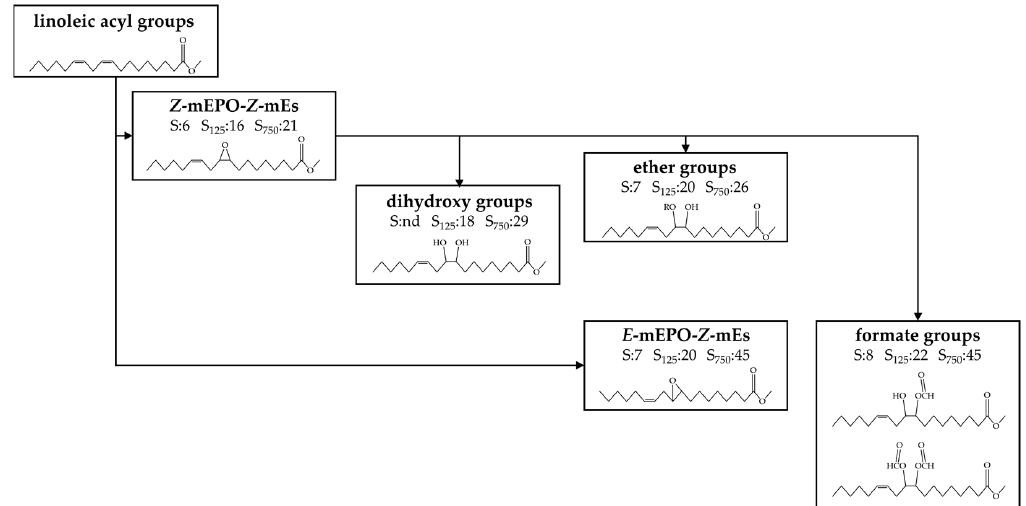
Figure 15. Oxylipins having their origin in the epoxidation of linoleic acyl group and oxirane ring opening, with an indication of the possible precursor [116–133] ordered from left to right and from top to bottom according to the beginning of their formation in samples S 125 and S 750 respectively, after being submitted to accelerated storage at 70 °C (nd: not detected).